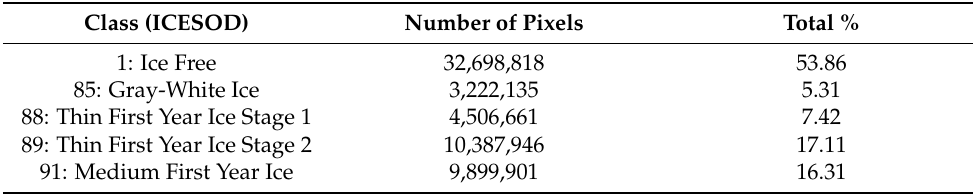
Table 4. Stage of Development classes.